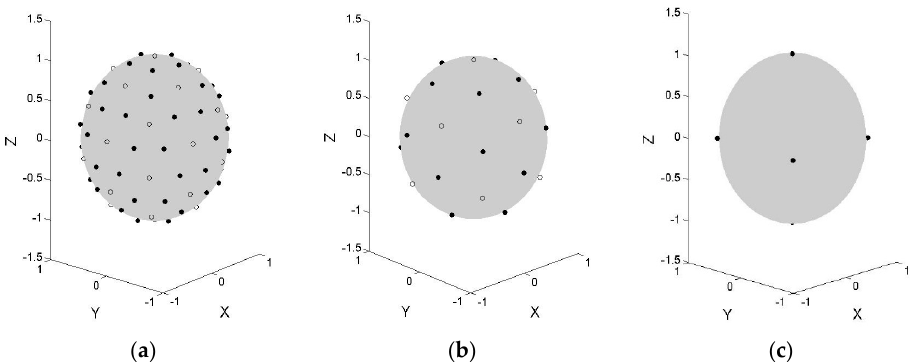
Figure 6. Points closest to the vertices and centers of the polygons of three polyhedrons. ( a ) Points on the 32-hedron; ( b ) Points on the dodecahedron; ( c ) Points on the octahedron.